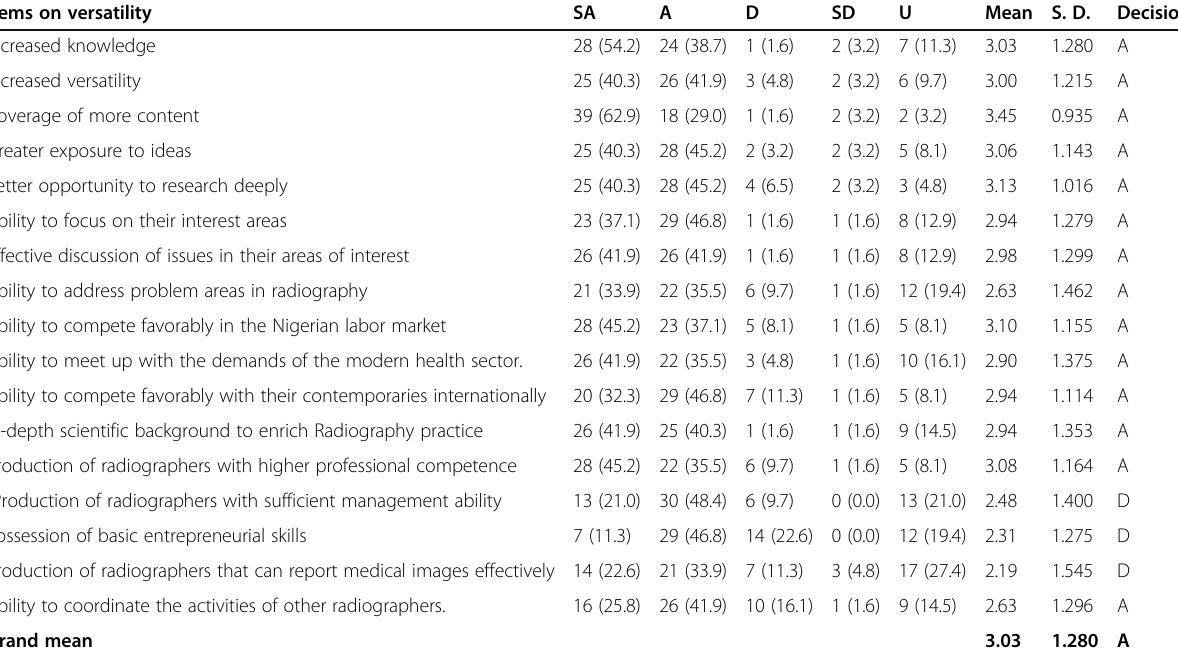
Table 2 Perception on versatility of radiographers that will be produced by the program Items on versatility